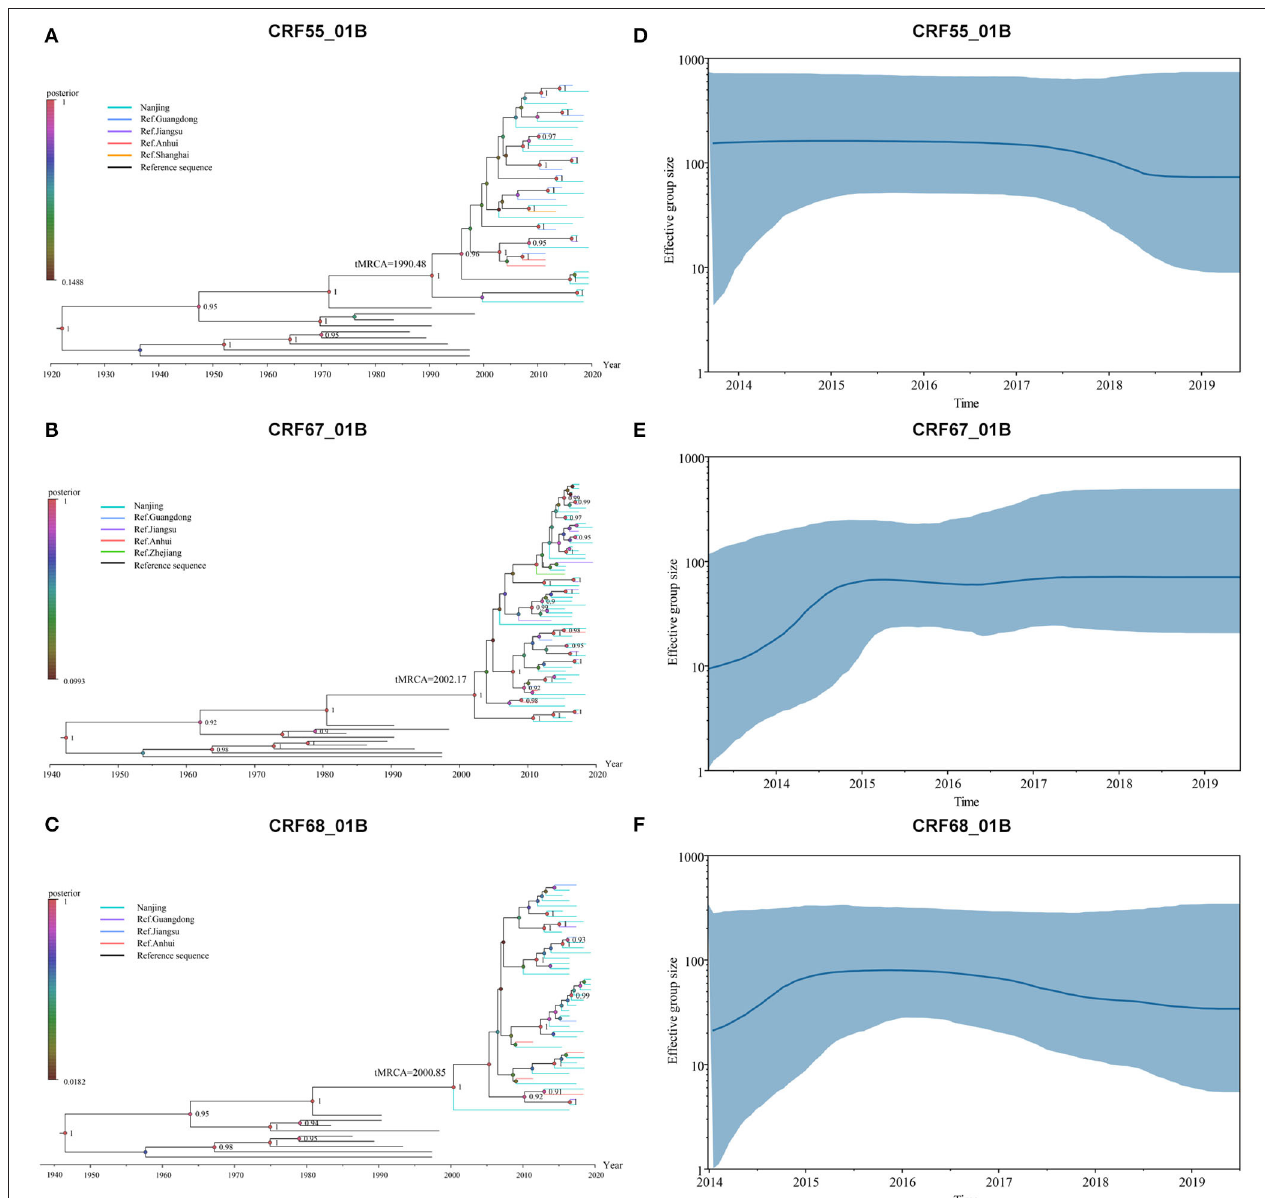
FIGURE 2 | Bayesian system evolution analysis of CRF01_AE/B recombinants. (A–C) The time to most recent common ancestor (tMRCA) of CRF55_01B (A) , CRF67_01B (B), and CRF68_01B (C) inferred by Bayesian evolution analysis. (D–F) Bayesian skyline plots for CRF55_01B (D) , CRF67_01B (E) , and CRF68_01B (F) in Nanjing. The line represented the effective sample size, and the shaded region depicted the upper and lower 95% highest posterior density interval (HPD) estimates.